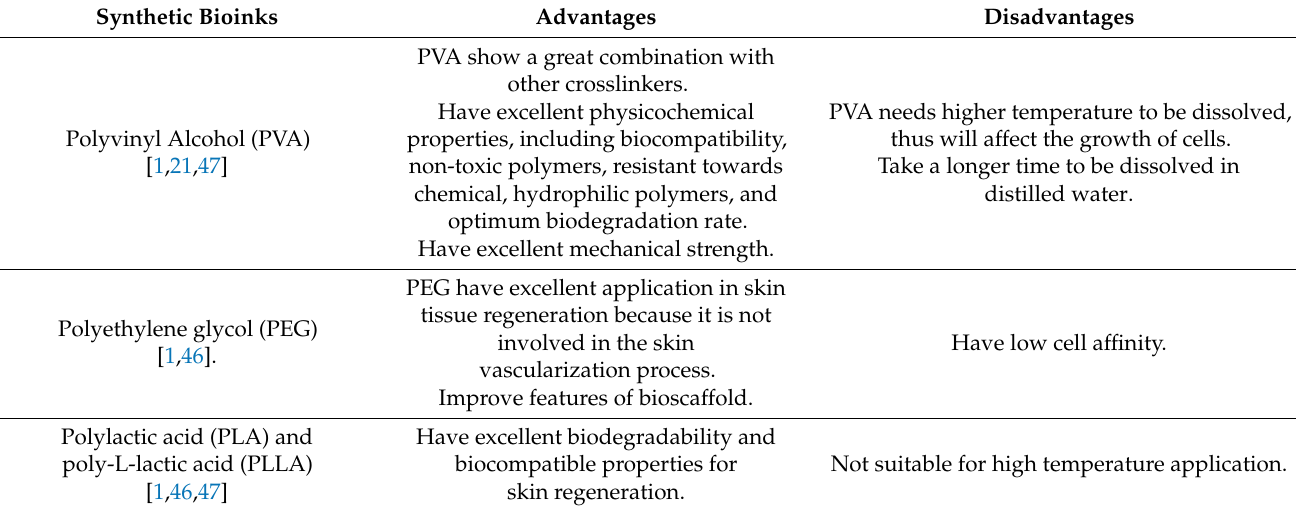
Table 3. The list of the advantages and disadvantages of skin regeneration applications for synthetic bioinks. Synthetic